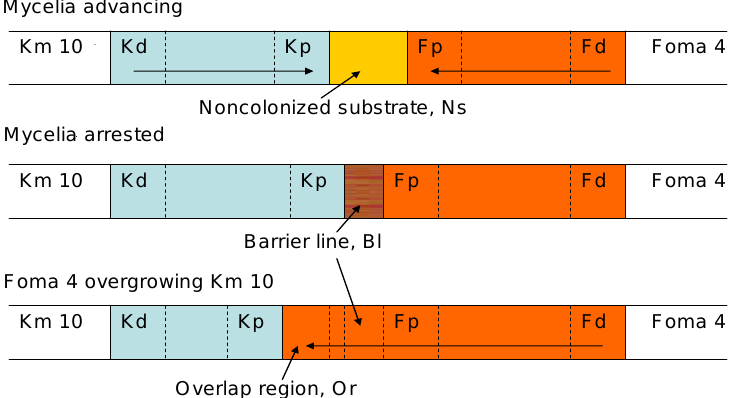
Figure 1. Denotation of the 1.2-cm substrate columns retrieved from situations distal (d) or proximal (p) to the advancing mycelial fronts, from central non-colonized substrate, the melanized barrier line sector and from overlap regions. The arrows indicate the direction of the mycelial advance.